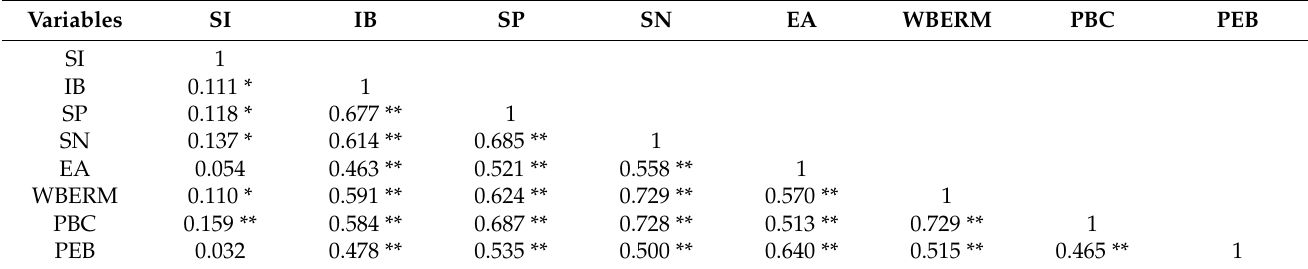
Table 4. Pearson’s r of the